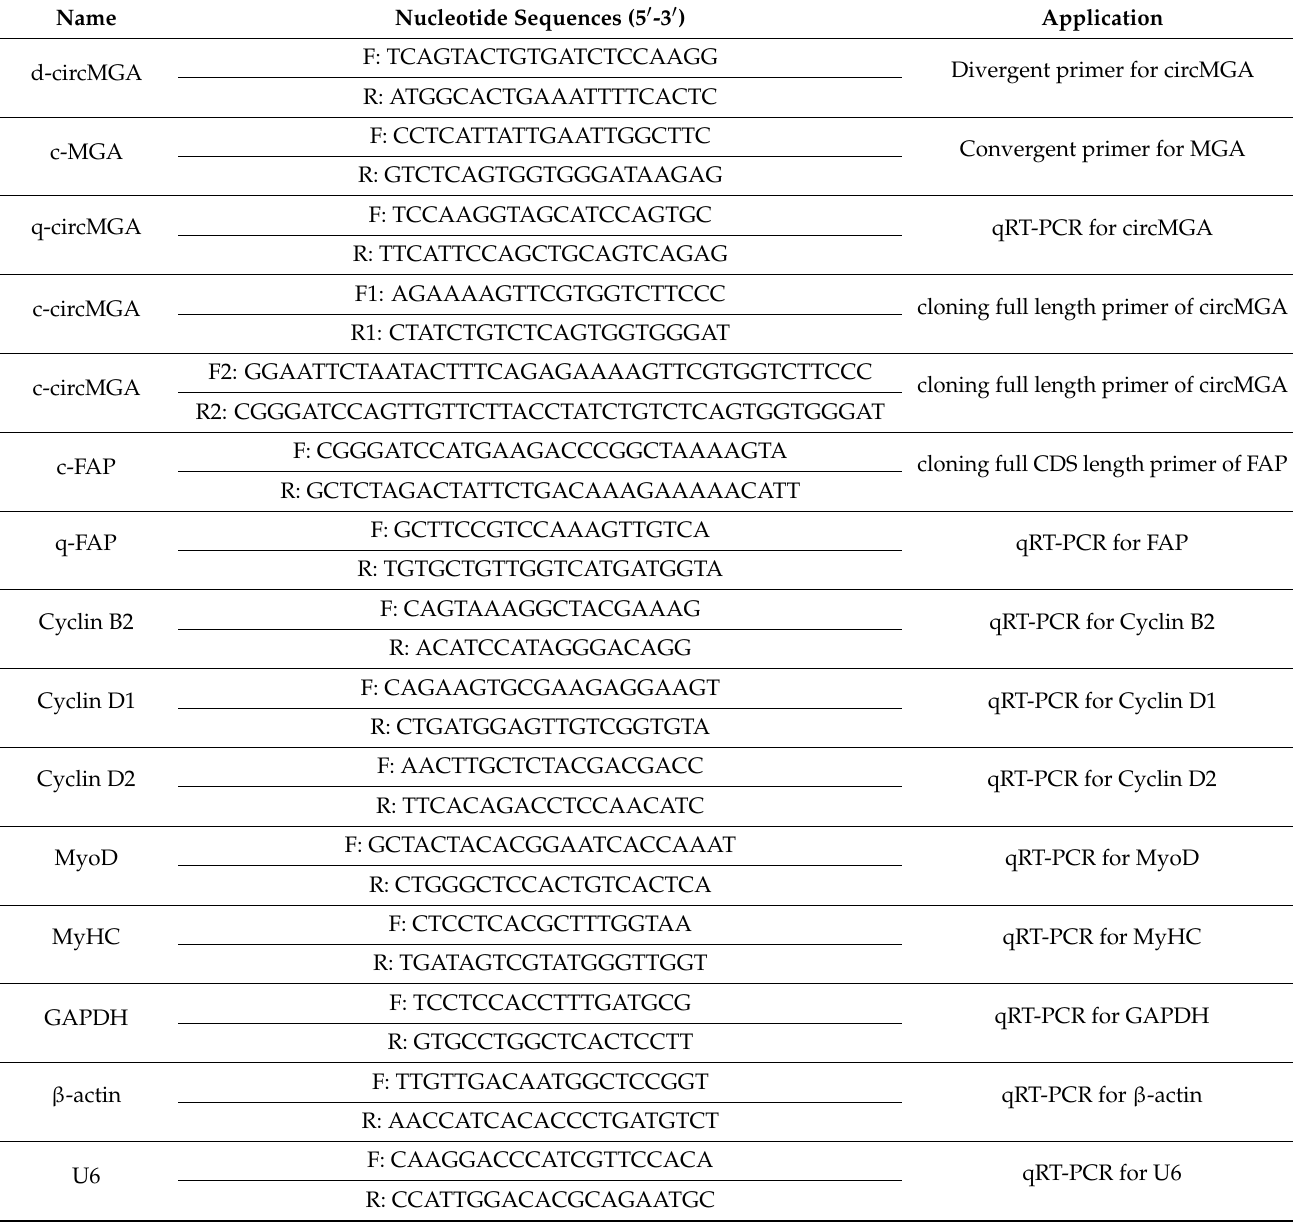
Table 1. Primers used in this study.